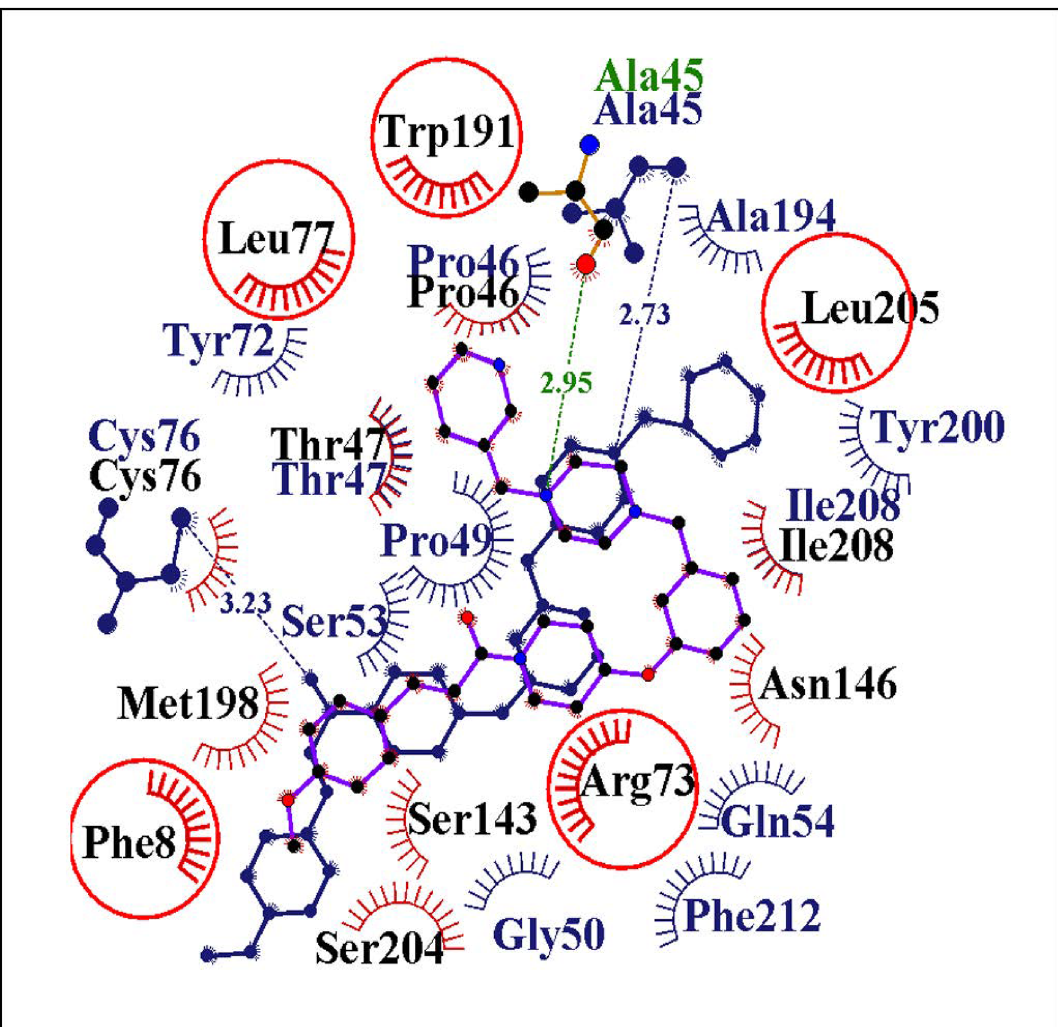
Figure 4. 2D interaction patterns of molecule 5 are shown overlapped between the initial docked pose and the most favourable conformation (biggest cluster pose) during the 100 ns molecular simulations. Blue coloured residues indicate initial docked poses and the red coloured residues belong to biggest cluster. Green coloured residues are hydrogen bonding residues. The 2D diagram shows that the van der Waals interactions are very strong as the common residues at the initial and biggest cluster pose are maximum in